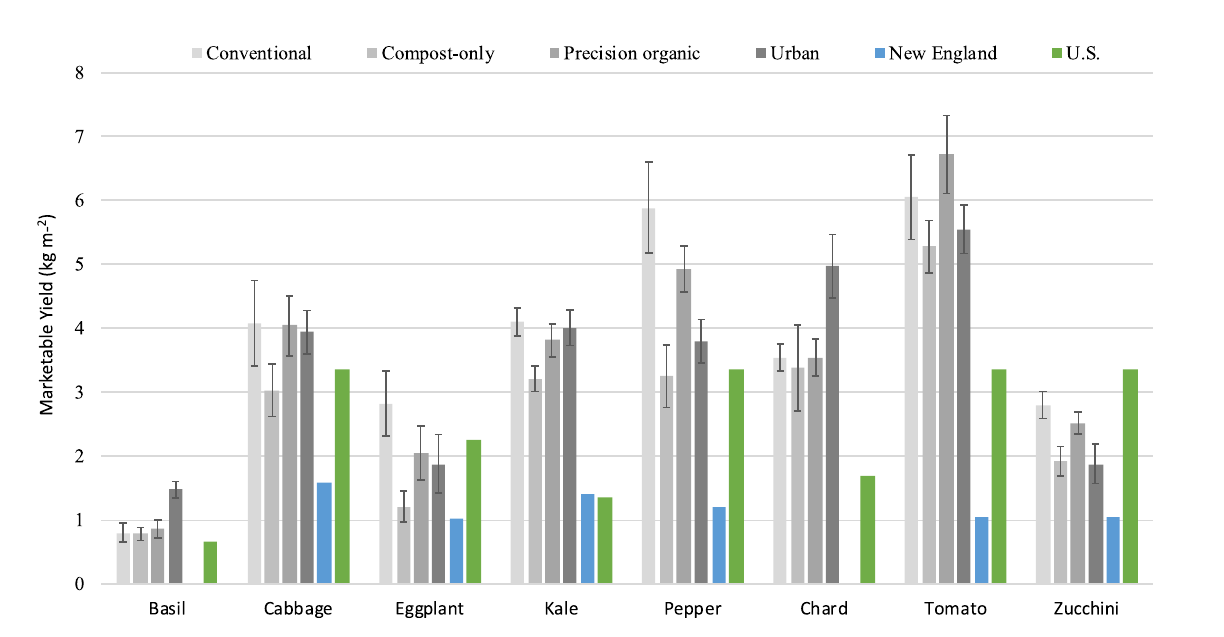
FIGURE 2 | Average yields of eight crops grown for two or more seasons, by system, vs. regional and U.S. averages. Error bars represent standard deviations of the